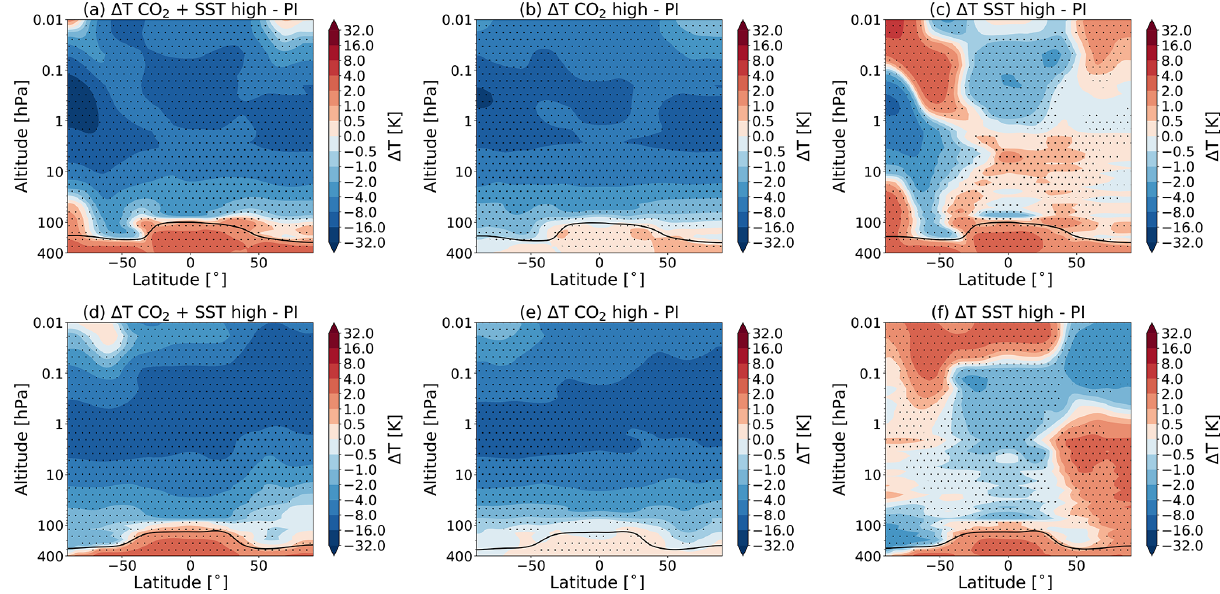
Figure 1. The total change in temperature in July (a–c) and January (d–f) for (a, d) the simulation with high CO 2 and SSTs (S3), (b, e) the simulation with high CO 2 (S1) and (c, f) the simulation with high SSTs (S2), all as compared to the pre-industrial control simulation (C1). The dotted regions indicate the regions where the data reach a confidence level of 95%. The black line indicates the tropopause height for experiments S3 (a, d) , S1 (b, e) and S2 (c, f)